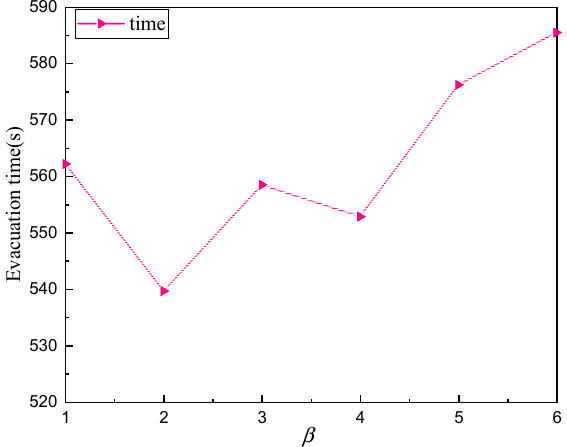
Figure 9. Effects of the expected heuristic factor β on evacuation time.